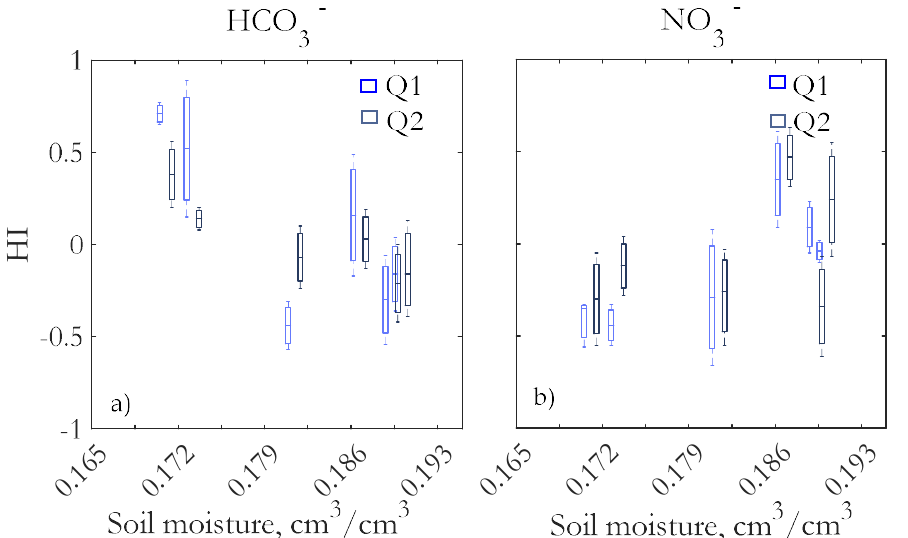
Figure 6. Relationships of the ( a ) HCO 3 − and ( b ) NO 3 − between soil moisture and hysteresis index (HI) for Q1 and Q2 locations along the Kanawha River indicated in Figure 1.